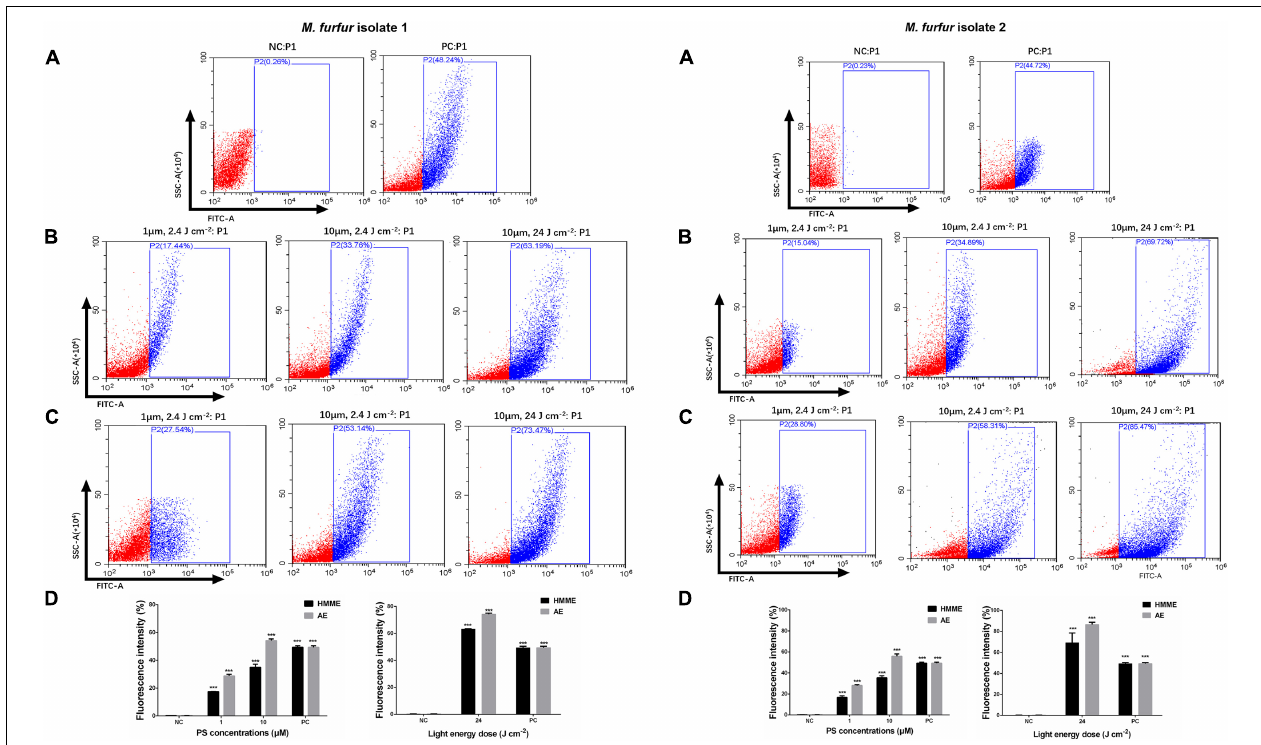
FIGURE 7 | Intracellular ROS accumulation in M. furfur cells after HMME and AE-mediated aPDT. (A) Fluorescence intensities of DCF in M. furfur cells (NC: without any treatment, PC: treated with 10 mM H 2 O 2 for 1 h); (B) fluorescence intensities of DCF in M. furfur cells treated with different concentrations of HMME and irradiated with different energy doses of light; (C) fluorescence intensities of DCF in M. furfur cells treated with different concentrations of AE and irradiated with different energy doses of light; (D) fluorescence intensities of DCF in M. furfur cells (NC: without any treatment, PC: cells treated with 10 mM H 2 O 2 for 1 h). Each value refers to mean ± standard deviation (SD; n = 3; ns: no significance, *** P <